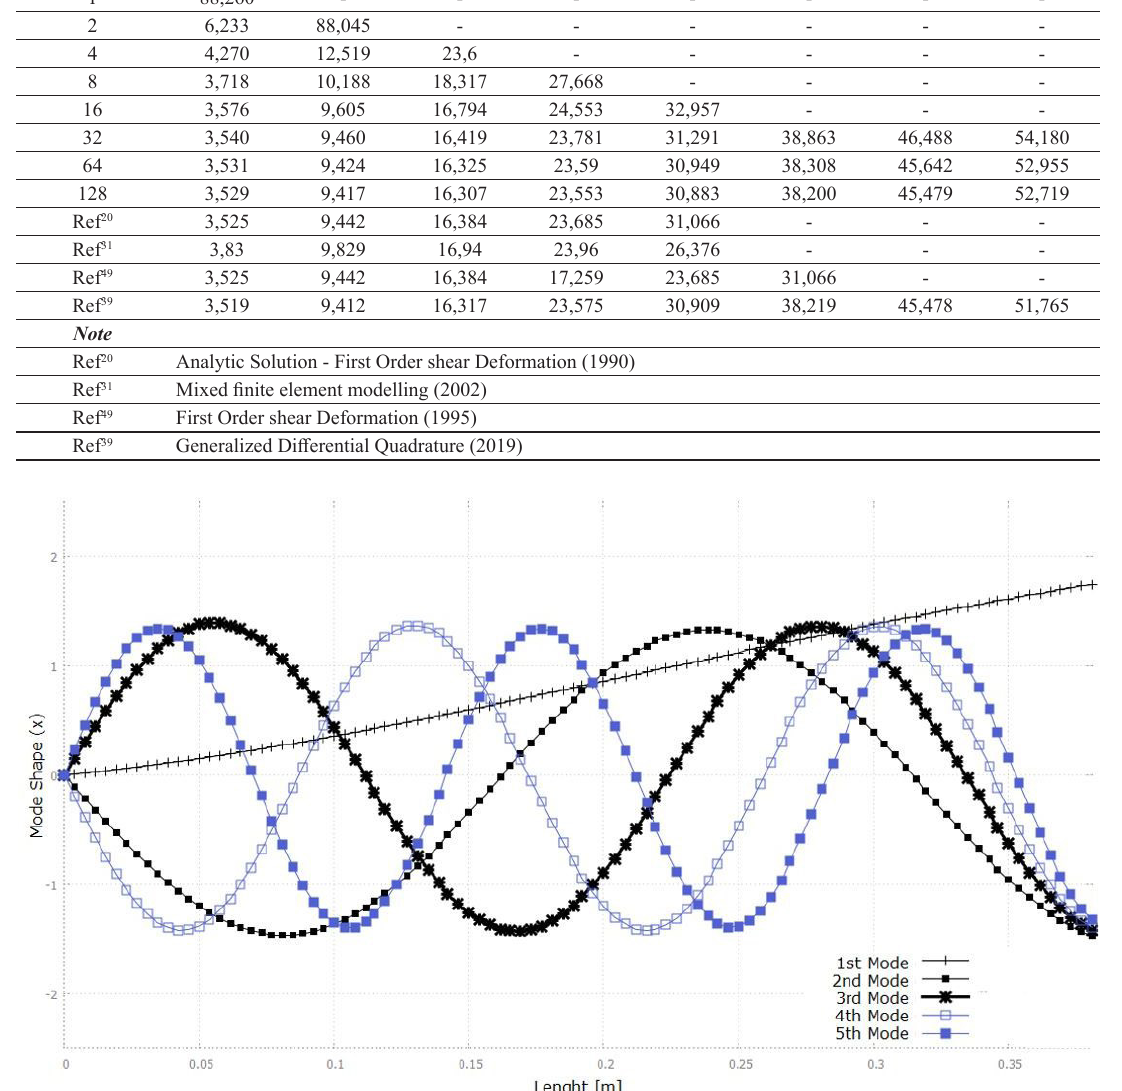
Figure 11. First five transversal mode shapes of the clamped-free (CF) beam computed using the corrected finite element